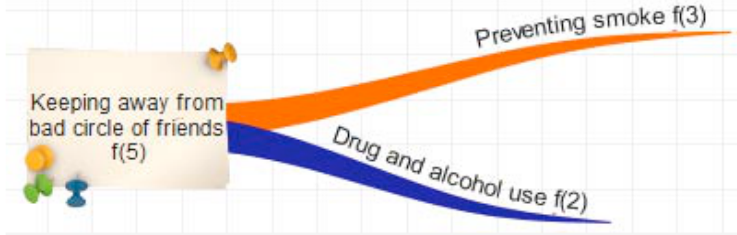
Figure 4. The category of keeping away from bad circle of friends